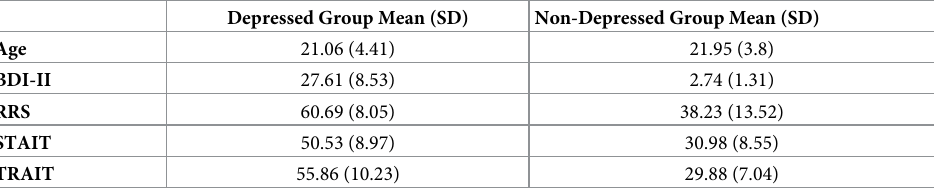
Table 1. Group differences in age, depression, rumination and anxiety